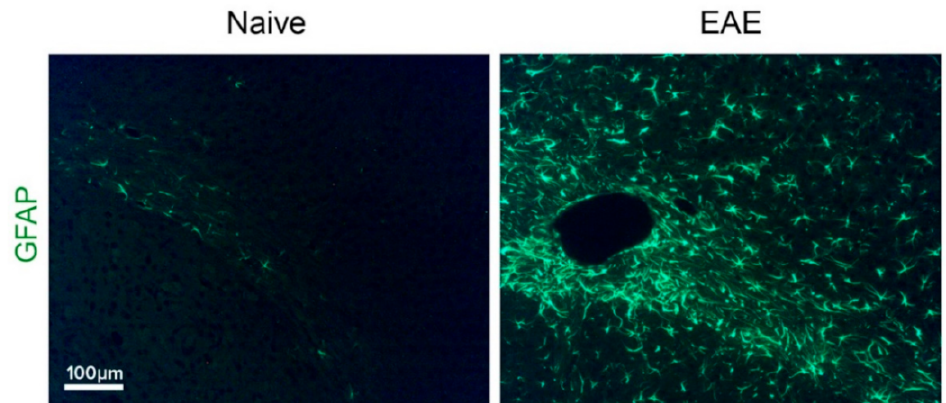
Figure 1. Astrogliosis in the somatosensory cortex of an EAE-induced mouse in comparison to a naïve mouse. Immunohistochemical staining for GFAP, 15 days after EAE-induction. Activated astrocytes produce or upregulate the secretion of various factors. These include cytokines e.g., TNF- α , IL-1 β , IL-6, and GM-CSF (Figure 2A); chemokines e.g., CCL2, CCL3, CCL5, CCL20, CXCL10, and CXCL12; and neurotrophic growth